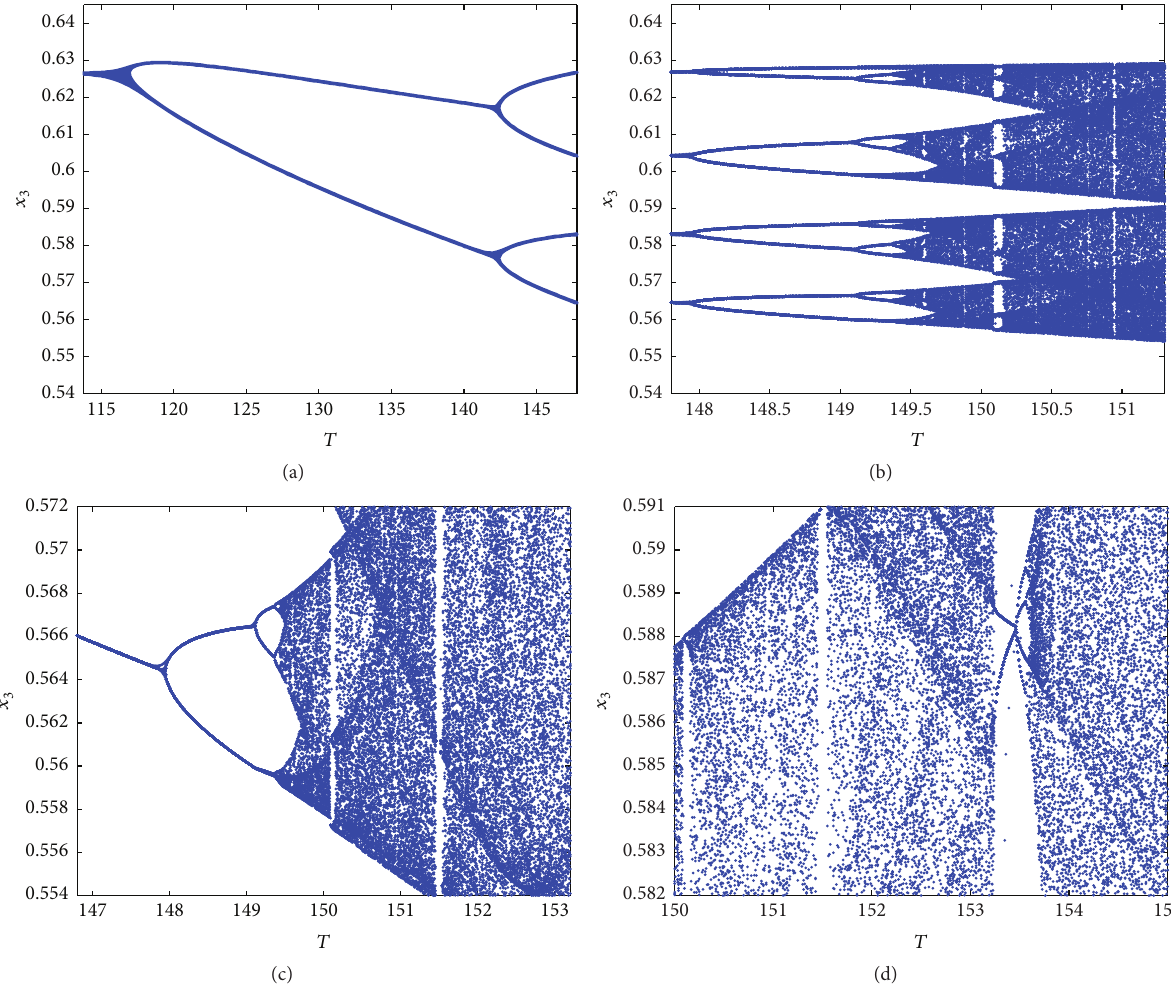
Figure 5: The magnified parts of Figure 4(c) of dynamic behavior of 𝑥 3 . (a) and (b) are period solutions. (c) is a typical chaotic oscillation when 𝑇 = 151.6 . (d) is the symmetry-breaking bifurcations when 𝑇 =